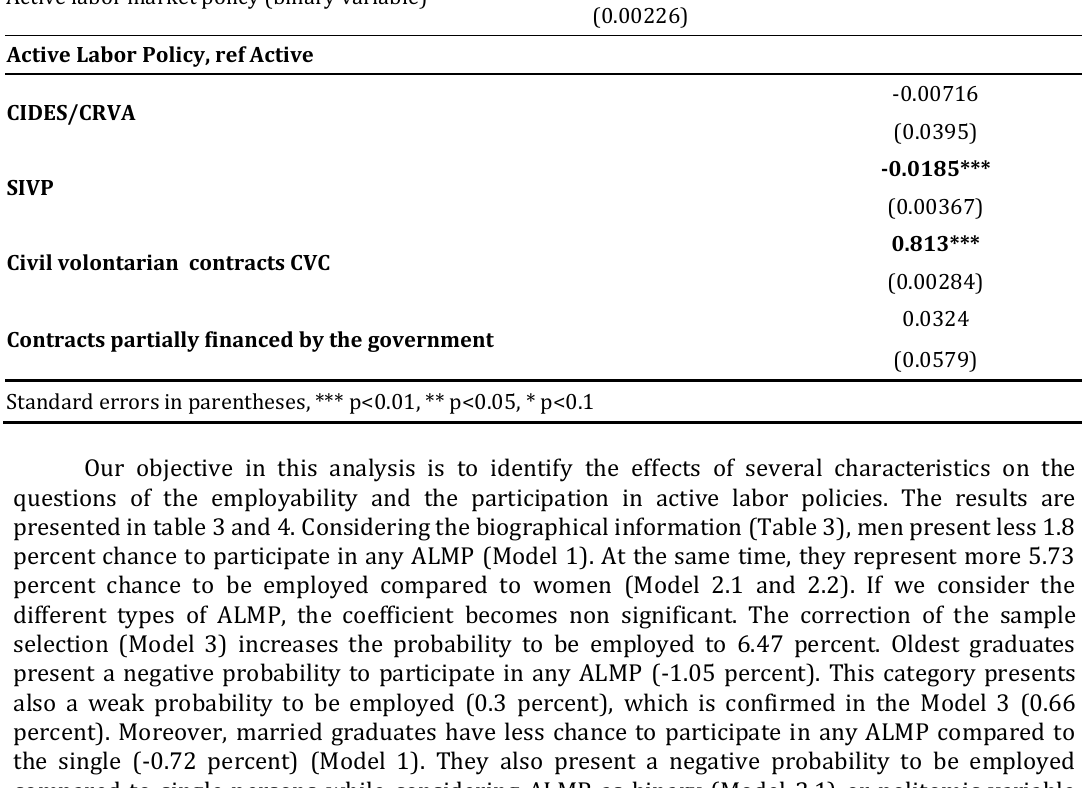
ALMP (Binary variable) Model 2.1